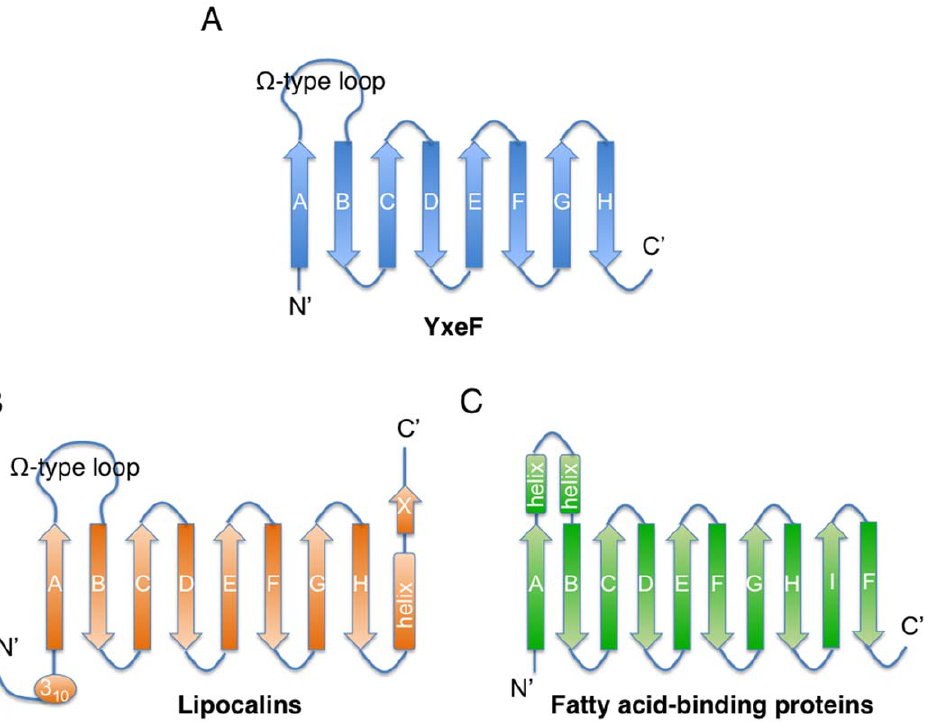
Figure 4. Schematic representation of secondary structure element topologies. (A) YxeF, (B) lipocalins and (C) fatty acid-binding proteins. b -strands are represented by arrows, a -helices by rectangles, and 3 10 -helices by ellipses. N- and C-termini are indicated as N and C respectively, and the ‘ V -type’ loop L1 shared by YxeF and lipocalins is labeled.